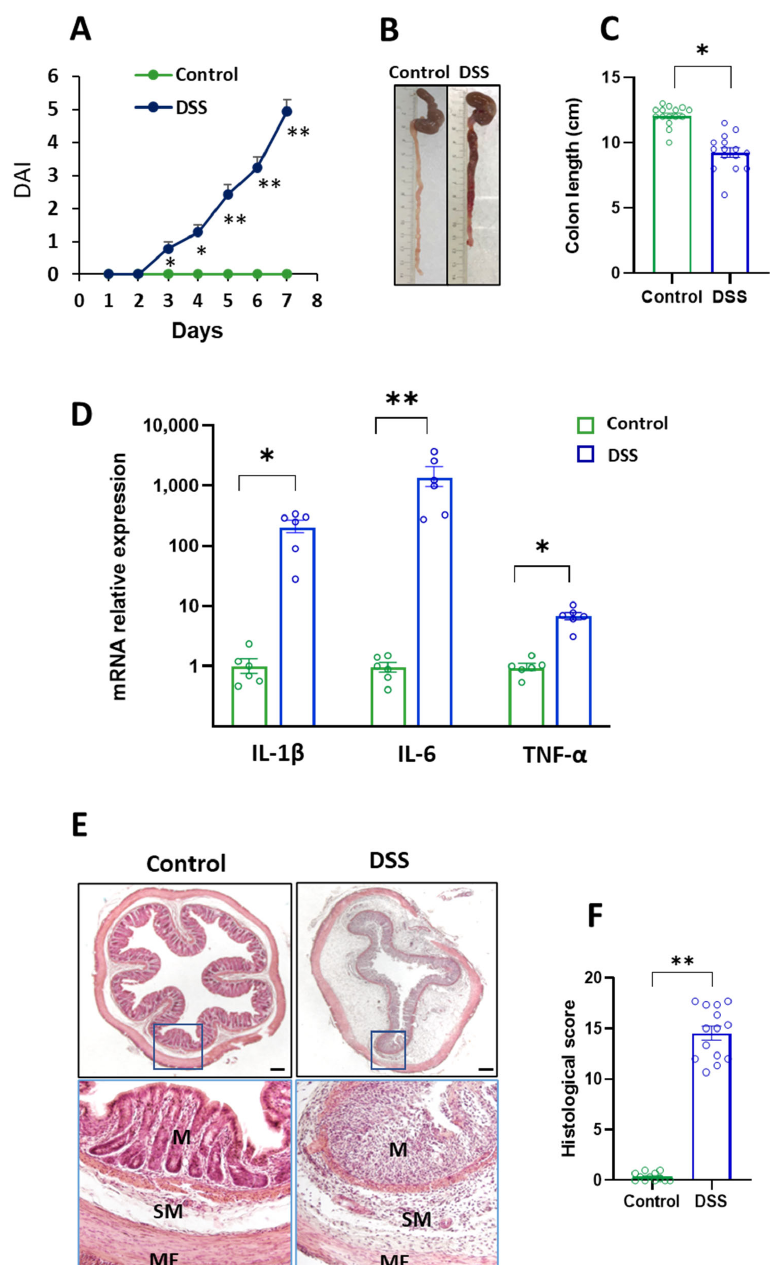
Figure 1. Evaluation of the DSS-induced acute colitis in rats. Control (untreated) and DSS-treated rats received either water or water containing 3% dextran sulphate sodium (DSS) for 7 days, respectively. ( A ) Disease activity index (DAI) assessed daily. ( B ) Representative macroscopic appearance of cecum and colon. ( C ) Colon length. ( D ) mRNA relative expression of pro-inflammatory cytokines in the distal colon. ( E ) Representative hematoxylin/eosin-stained sections of histological analysis. ( F ) Score of distal colon damage. M: mucosa, SM: submucosa, ME: muscularis externa. Scale bar represents 200 µ m. Data are means ± SEM ( n = 8–15 animals per group). Student’s t -test: * p < 0.05 and ** p < 0.01, DSS-treated rats vs.